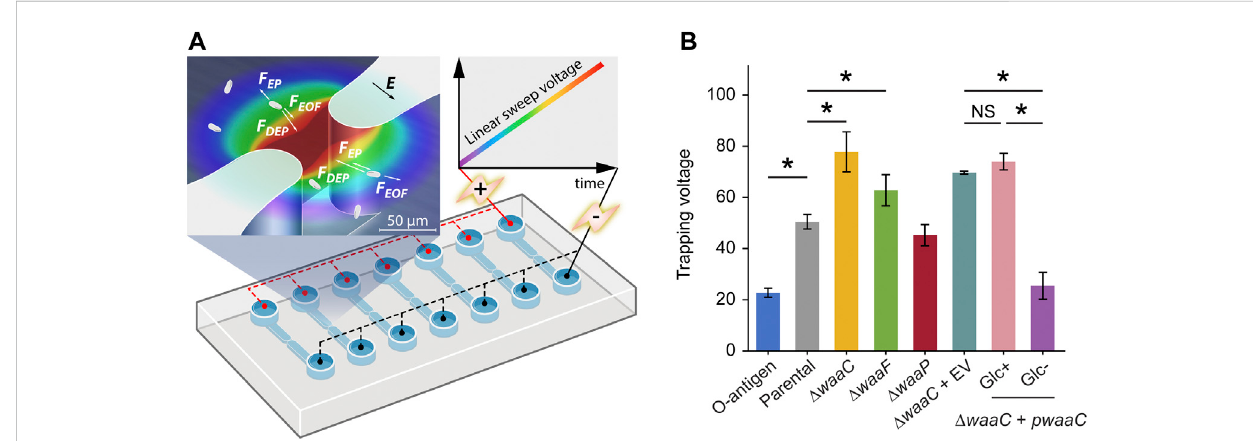
Immobilizing LPS mutants using 3D insulator-based dielectrophoresis (3DiDEP). (A) Schematic of a micro fl uidic device with an array of 3DiDEP microchannels. Dimensions of the 3D microchannel geometry are shown in Supplementary Figure S1. A DC potential difference increasing linearly with time at 1 V/s was applied across the channel. Magni fi ed view of the 3D constricted region depicts the 3DiDEP trapping principle: bacteria near the constriction are immobilized when the DEP force balances drag forces due to background electroosmotic (EOF) fl ow and electrophoresis (EP). Electric fi eldintensityisillustratedinthebackgroundcolorscale(darkredindicateshighervalues). (B) Measuredtrappingvoltage(thresholdvoltageatthe onset of cell trapping) for each strain. Error bars indicate standard deviations. Asterisks indicate statistical difference (* p < 0.05, NS: not signi fi